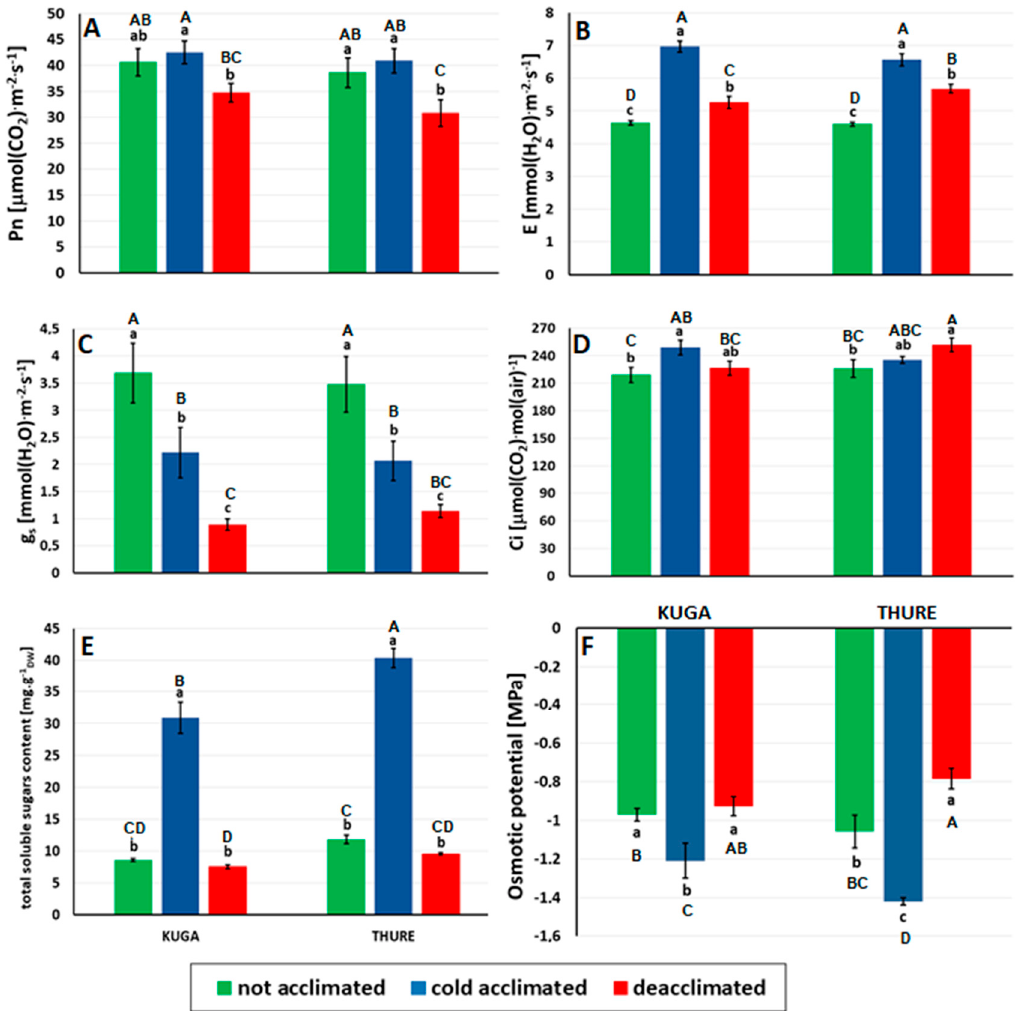
Figure 5. Gas exchange, total soluble sugars, and osmotic potential in the leaves of the not acclimated, cold-acclimated, and deacclimated oilseed rape cv. Kuga and cv. Thure; ( A ) net photosynthesis (Pn), ( B ) transpiration rate ( E ), ( C ) stomatal conductance (g s ), ( D ) intercellular CO 2 concentration, ( E ) total content of soluble sugars, and ( F ) osmotic potential. Mean values ± SD marked with the same letters did not differ significantly at p ≤ 0.05 according to Duncan’s test, n = 10 for gas exchange, n = 5 for content of sugars, and n = 7 for osmotic potential; lowercase—comparison separately within each cultivar, uppercase—comparison between cultivars.